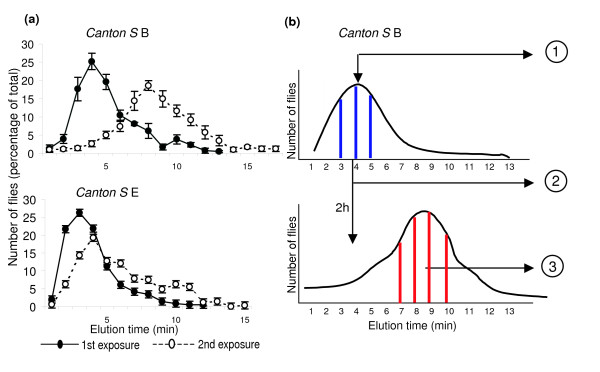
Sensitivity and development of tolerance to alcohol in Drosophila melanogaster. (a) Inebriometer elution profiles of Canton S B and Canton S E flies after exposure to concentrated ethanol vapor. Note the shifts in peak elution time between the first (solid symbols) and second (open symbols) ethanol exposure, and the difference in this peak shift between Canton S B and Canton S E. (b) Schematic diagram of the experimental design used to assess whole genome transcriptional changes after ethanol exposure. The numbers indicate samples collected for microarray analysis, as follows: 1, control flies; 2, flies after a single exposure to ethanol; 3, flies that develop tolerance during a 2 h interval prior to a second exposure to ethanol.